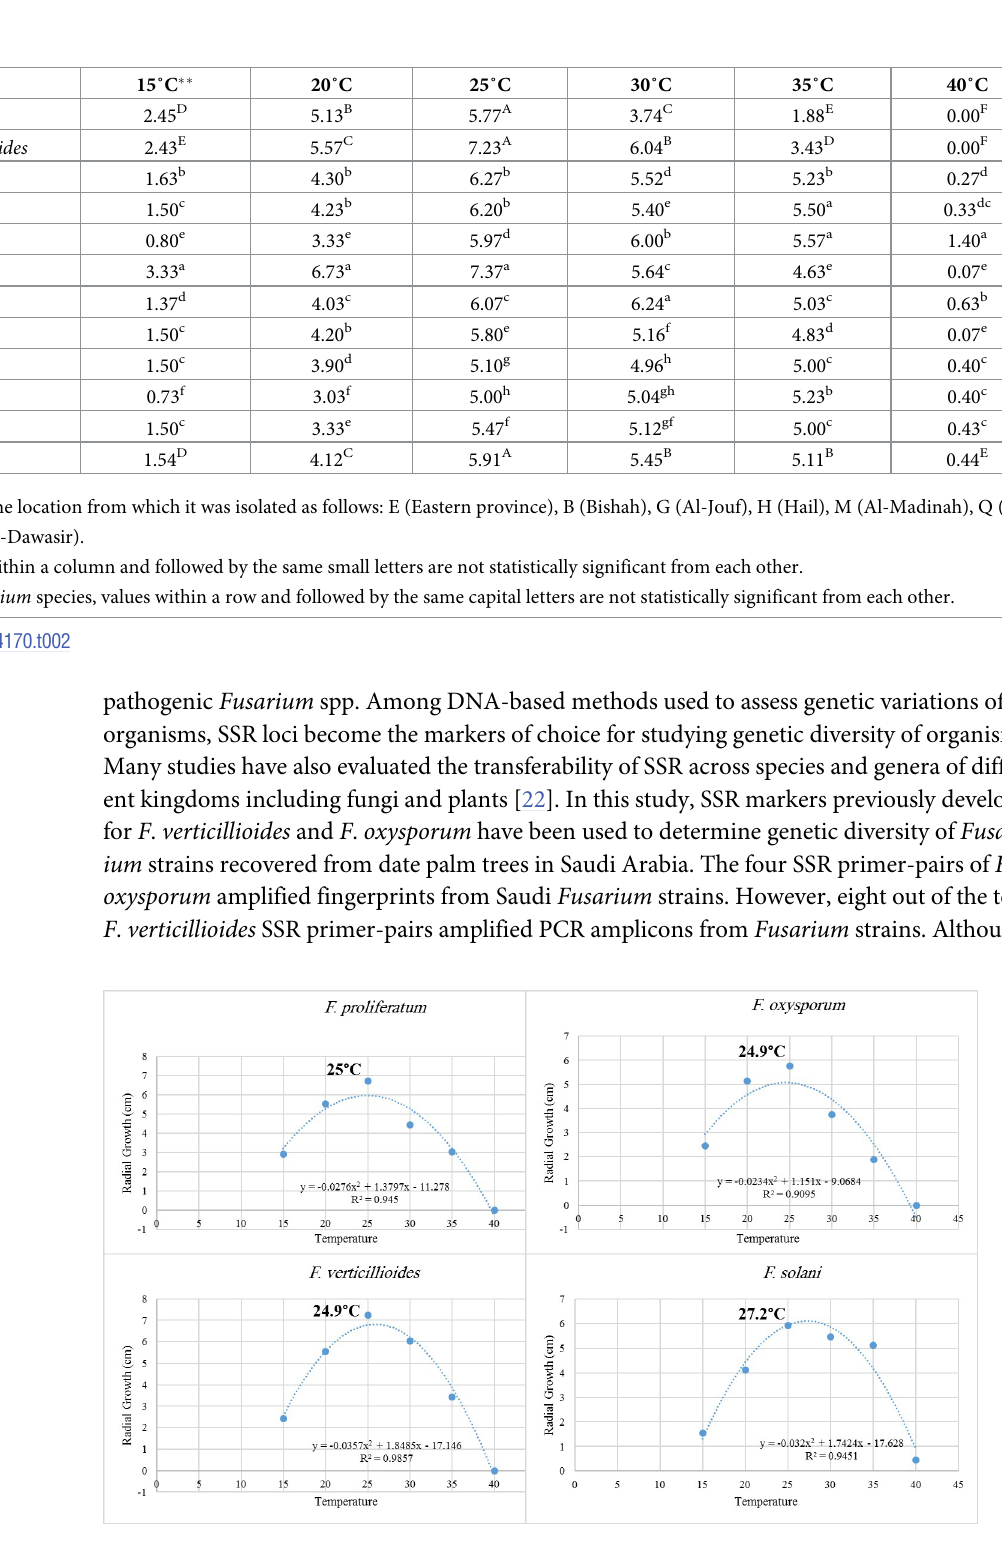
Fig 3. Estimation of optimum mycelial growth of four Fusarium species grown at different temperatures using the polynomial regression model.